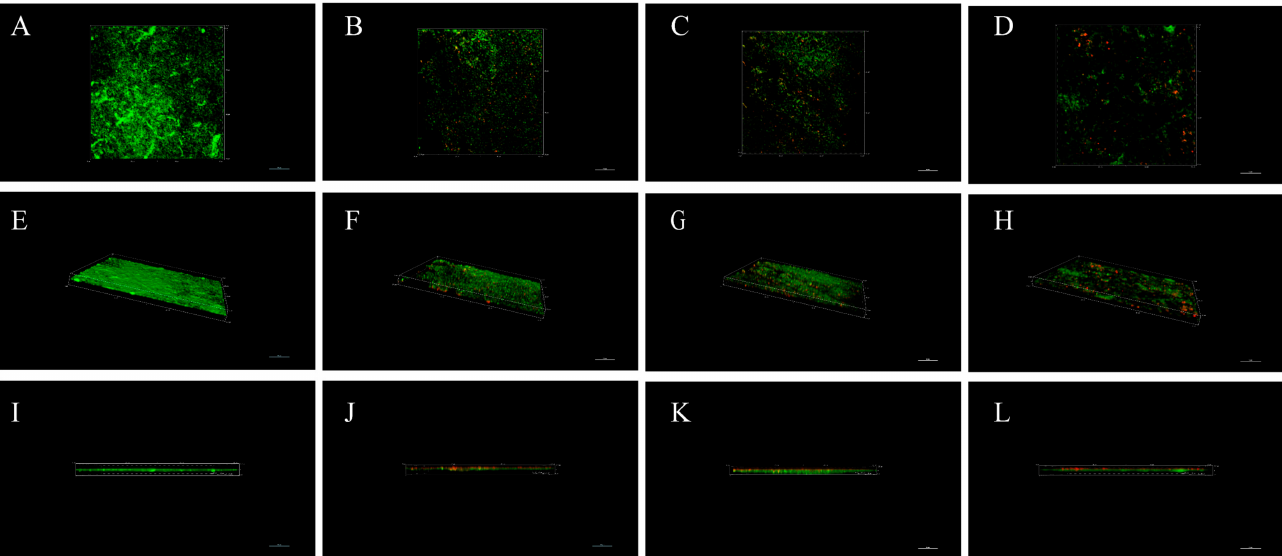
Figure 8. CLSM of the H. pylori 3192 biofilm under different treatments. ( A – D ) was the main view (observed horizontally along the x–y axis, E – H ) was the view at a certain angle, ( I – L ) was the side view (observed horizontally along the x–z axis). Control: ( A , E , I ); 1/2 × MIC of LN12 CFS treatment: ( B , F , J ); 1 × FIC of AMX and CLR treatment: ( C , G , K ); 1/2 × MIC of LN12 CFS in combination with 1 × FIC of AMX and CLR treatment: ( D , H , L ). The scale bar is 10 µ m. AMX: Amoxicillin, CLR: